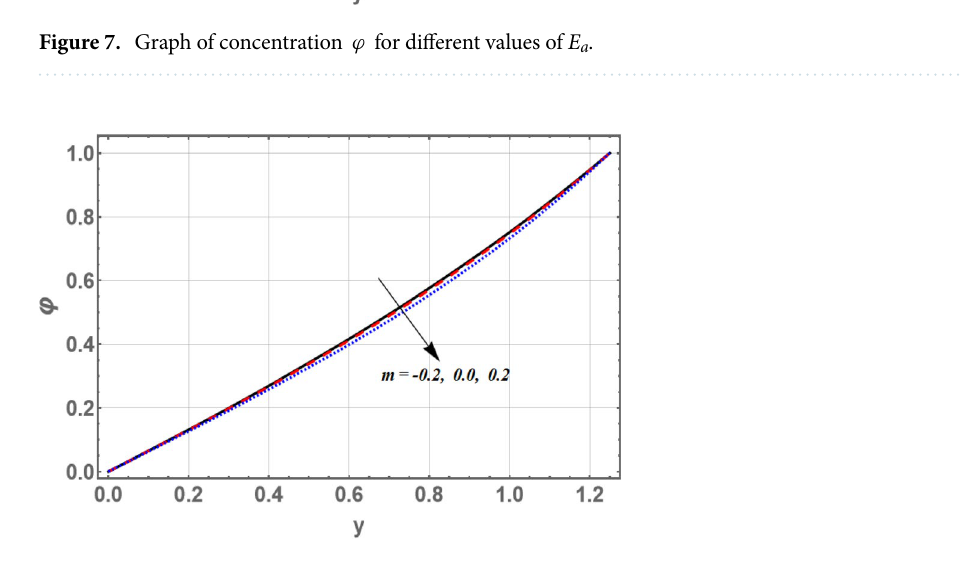
Figure 8. Graph of concentration ϕ for different values of m